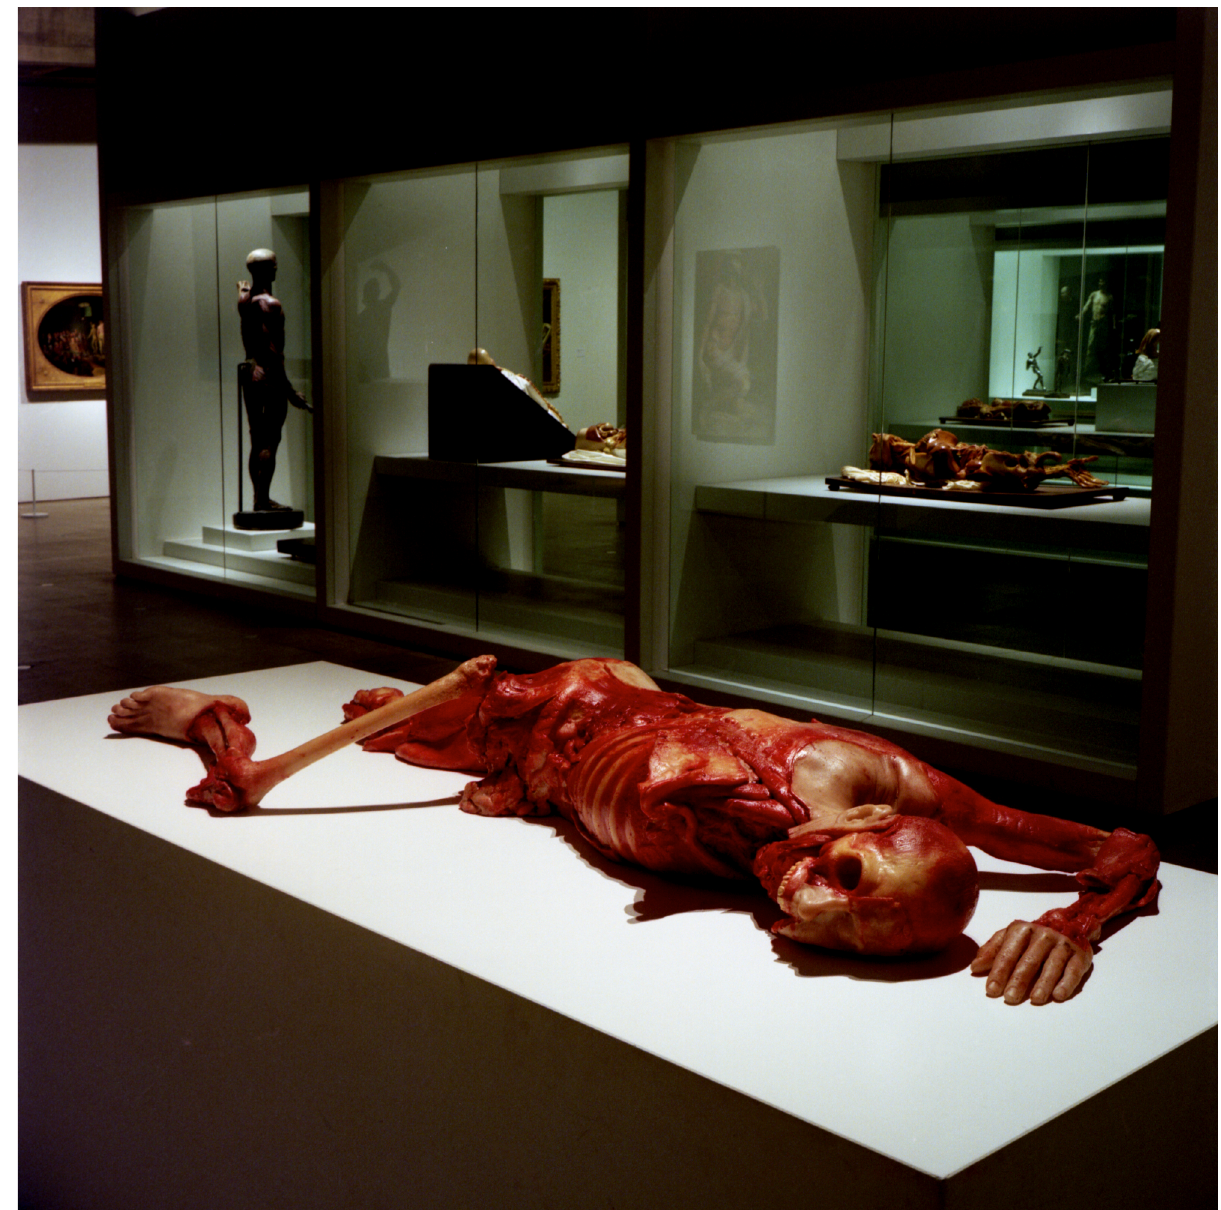
Figure 4 | John Isaacs, A Necessary Change of Heart, 1999. Courtesy of Aeroplastics contemporary,